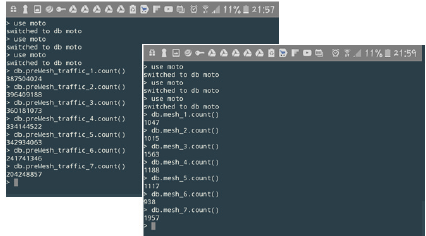
Figure 6: Output of the number of records before and after applying fuzzy